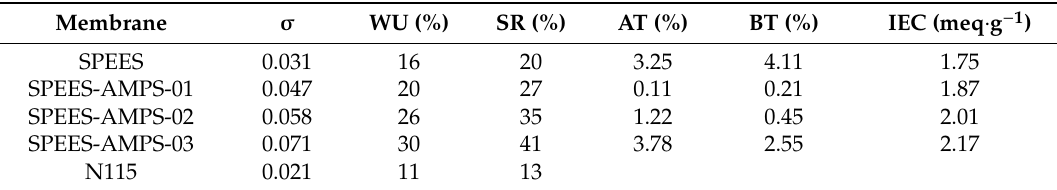
Table 2. Solubility